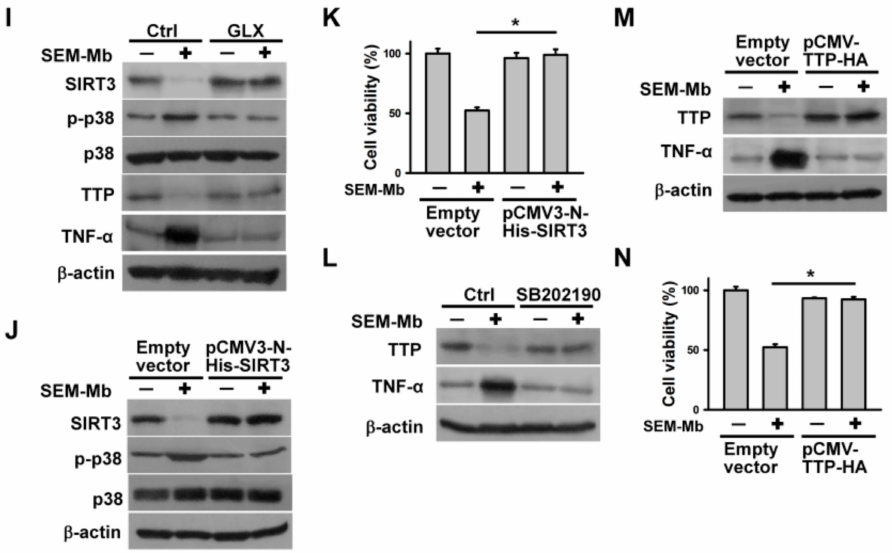
Figure 7. SEM-Mb-induced HL-60 cell death was associated with increased TNF- α expression triggered by the NOX4/SIRT3/p38 MAPK/TTP axis. Without specific indication, HL-60 cells were treated with 2 µ M SEM-Mb for 24 h. HL-60 cells were pre-treated with 10 µ M Z-DEVD-FMK, 10 µ M Z-IETD-FMK, 10 µ M BAPTA-AM, 10 µ M GLX351322, 10 µ M Mito-TEMPO, or 10 µ M SB202190